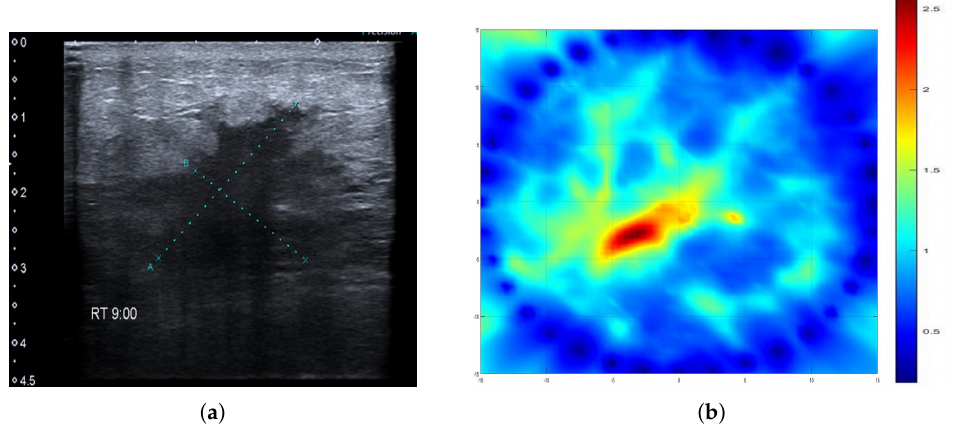
Figure 3. Comparison of SAFE lesion detection with clinical ultrasound: ( a ) ultrasound scan showing malignant lesion in the right breast and ( b ) SAFE scan showing the concordance with ultrasonogra-